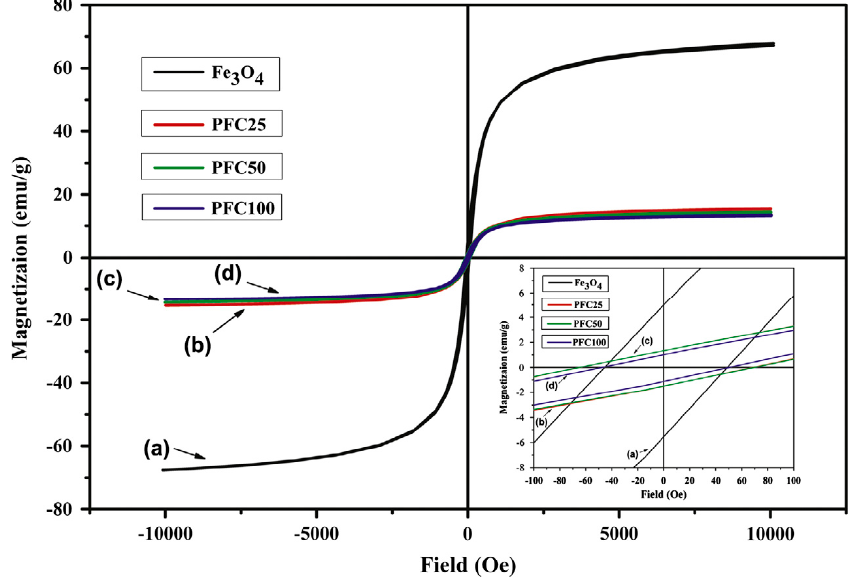
Figure 27. Magnetic hysteresis loop for Fe 3 O 4 and PCL/MWCNT/Fe 3 O 4 composites [31].